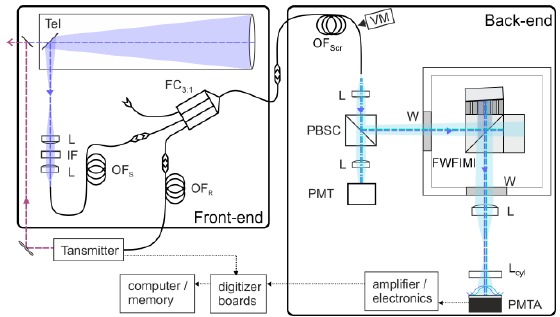
Figure 2: Simplified synopsis of FWFIMI-based Doppler Wind Lidar, technical details in the